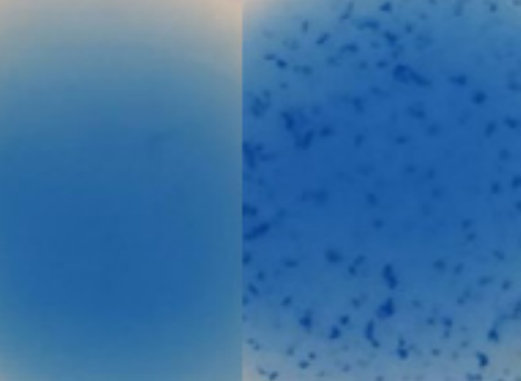
Figure 2. Staphaurex latex agglutination test results (left—negative, right—positive).